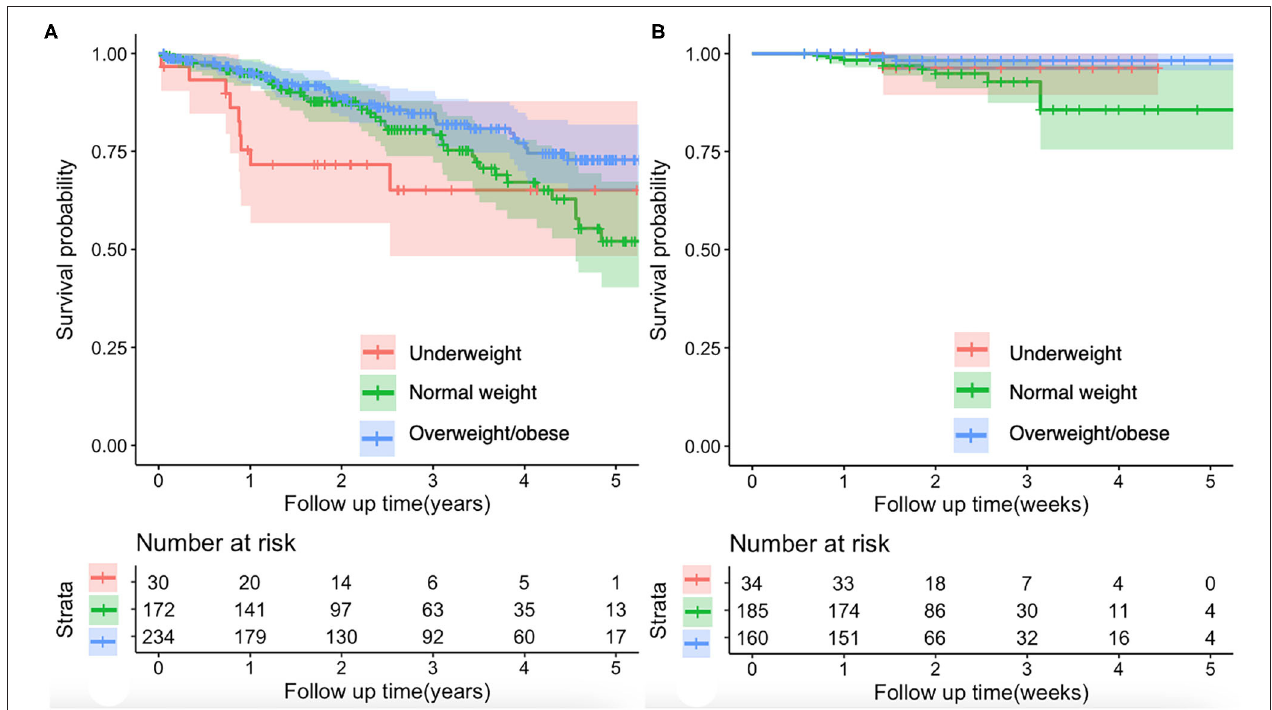
FIGURE 2 | Kaplan–Meier curves showing the effect of BMI on the mortality of patients with cirrhosis. (A) Long-term mortality of patients with cirrhosis. There was no significant difference in the cumulative survival rate between normal weight and underweight groups (log-rank test, p = 0.190). The overweight/obese group had a significantly higher cumulative survival rate than the normal weight group (log-rank test, p = 0.047). (B) In-hospital mortality of patients with cirrhosis and with AGIB. There was no significant difference in the cumulative survival rate between normal weight and underweight groups (log-rank test, p = 0.491) or between normal weight and overweight/obese groups (log-rank test, p = 0.094). AGIB, acute gastrointestinal